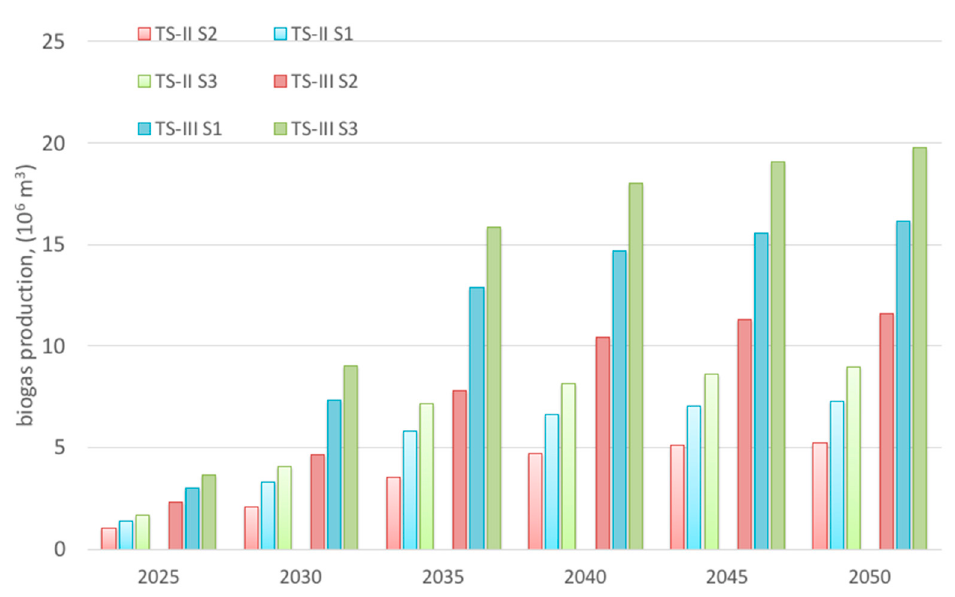
Figure 10. Biogas potential prediction until 2050 under scenarios TS ‐ II and TS ‐ III.